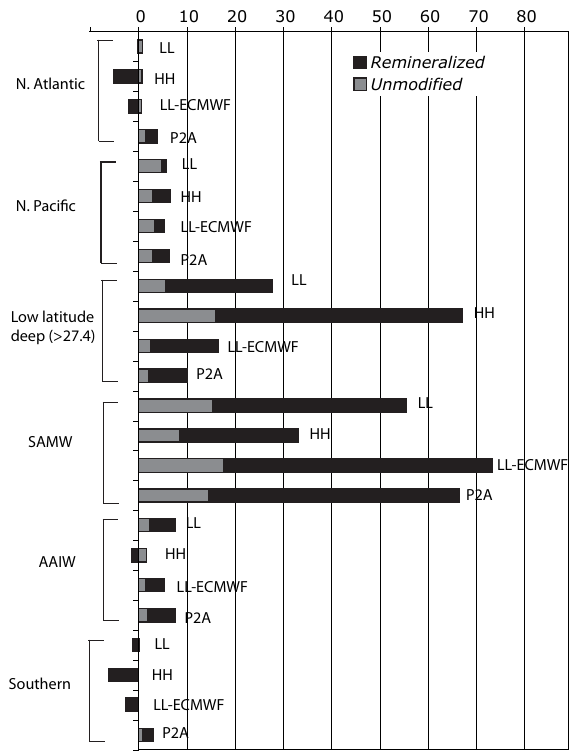
Fig. 13. Percentage of low latitude (30 ◦ S–30 ◦ N) export produc- tion fueled by nutrients from different tagged regions, separated by unmodified and remineralized components and by model configura- tion. The salient feature of the graph is that a majority (57–75%) of low latitude productivity is sustained by SAMW nutrients, except in the HH model configuration (33%). Approximately a third of the SAMW nutrients sustaining low latitude productivity are from the unmodified pool, which resemble preformed nutrients when the tags are deployed in the surface mixed layer. Negative values for remineralized tags indicate that unmodified DOP tagged in a given source region is respired to phosphate at a greater rate than the rem- ineralized PO 3 − fuels export production. Such is the case for al- 4 most all of the Southern DOP and much of the North Atlantic DOP